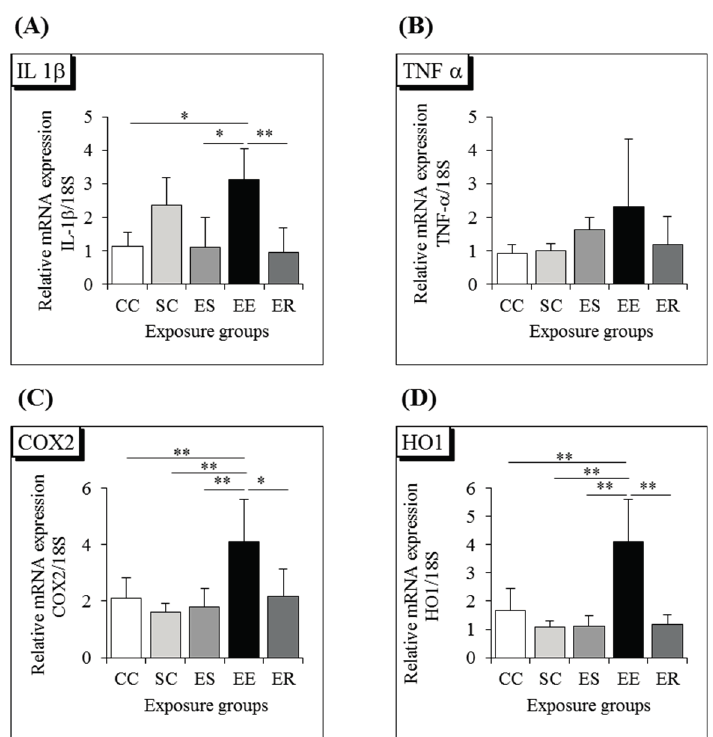
Figure 3. Messenger RNA expression level of proinflammatory cytokines ( A ) IL-1 β , ( B ) TNF- α , the inflammatory marker ( C ) COX2, and the oxidative stress marker ( D ) HO1 in the hippocampi of CC, SC, EE, ES, and ER groups of 7-week-old male mice. Each bar represents the mean ± SD ( n = 6, ** p < 0.01, * p < 0.05).